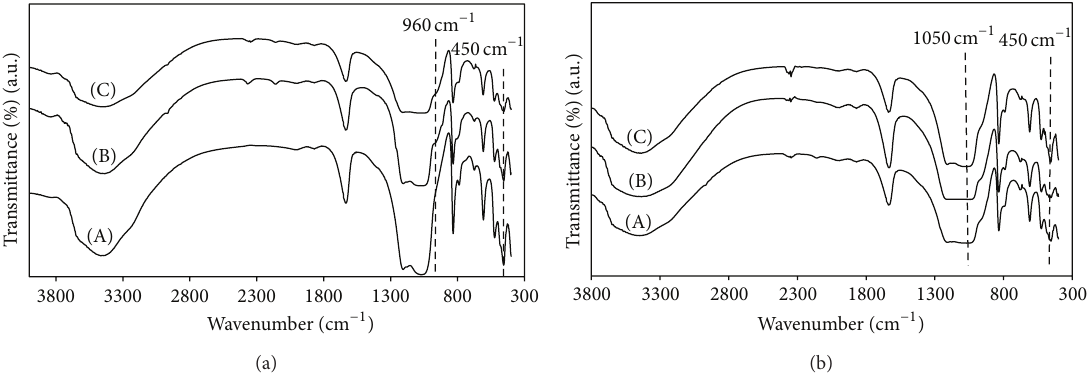
Figure 2: (a) FTIR spectra of NaY (A), Ti 2 -NaY (B), and Ti 4 -NaY (C). (b) FTIR spectra of Ti 4 -NaY (A), 0.64% La/Ti 4 -NaY (B), and 1.32% La/Ti 4 -NaY (C).